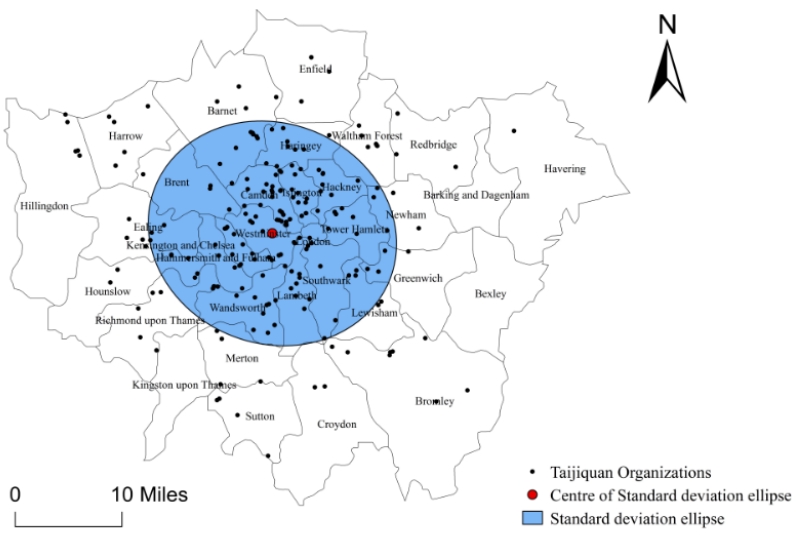
Figure 3. Direction Distribution Map for Taijiquan Organizations in London. The average distance of expected spatial distribution for the 208 Taijiquan organiza- tions in London is 1524 m, and the actual average distance calculated with ArcGIS10.3 software is 2247 m with its nearest neighboring point index R-value reaching 0.68, which shows that the spatial distribution of Taijiquan organizations in London is an agglom- erated type, showing a cohesive distribution. The geographic concentration index G of 208 Taijiquan organizations in London is 22.05, which is much higher than the average index G value of even distribution in all boroughs (G value 6.3), which indicates that the distribution agglomeration of Taijiquan organizations in London is high in Camden, Islington, Barnett, and Wandsworth (Figure